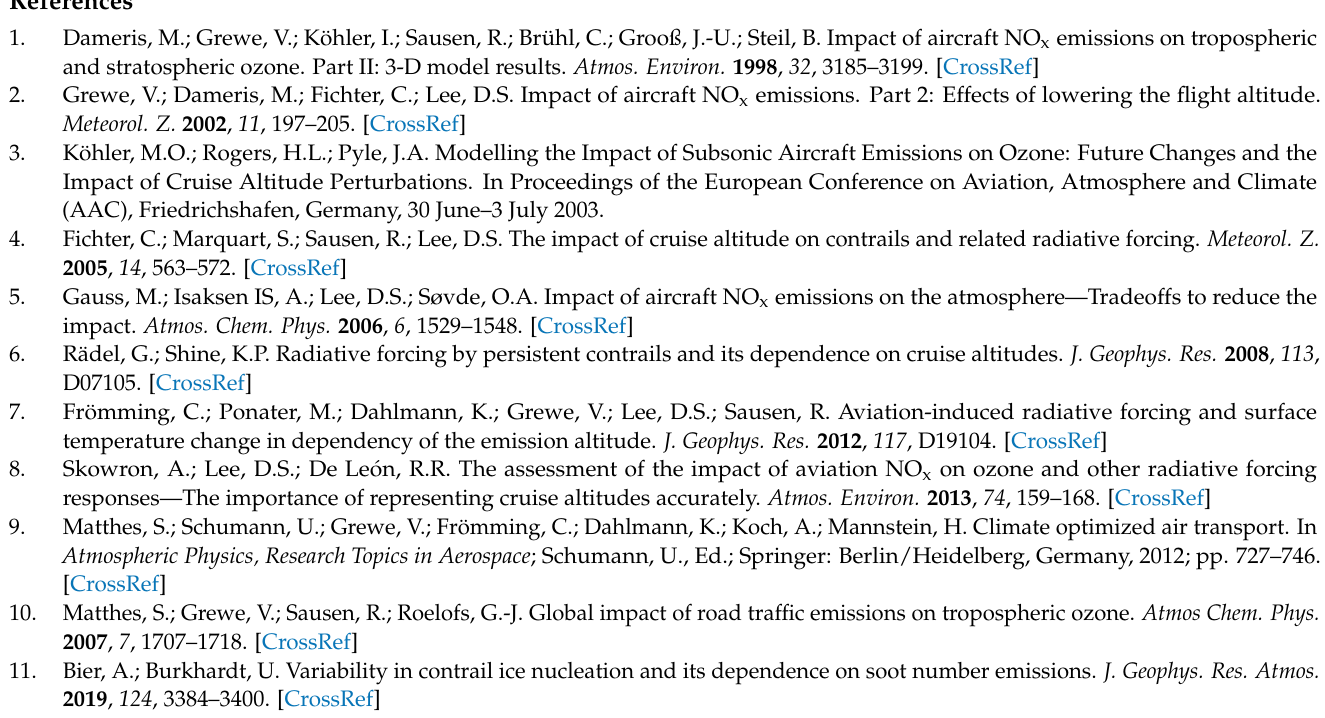
It should be noted here that when quantifying impacts with a perturbation approach, a nonlinear behavior can lead to results being dependent on the order in which individual sectors or contributors are analyzed. In the case of a saturation effect, the sector that is added last receives a lower attribution of the overall impacts, while those sectors added previously are attributed a proportional behavior, resulting in a higher efficiency, e.g., for ozone production. In the case of a tagging approach, nonlinearities are evenly distributed over and shared between individual sectors or contributors. From this sensitivity study, we estimate that adjusted radiative impacts of aviation induced effects updates presented in [16], resulting in an overall radiative impact of nitrogen oxides of 20 mW/m 2 in the reference case comprising all indirect effects. When aircraft are flying lower, radiative forcing decreases to 17.6 mW/m 2 , while radiative forcing increases to 22.6 mW/m 2 when aircraft are flying higher, as was also presented in